Question: Write a descriptive caption for this figure.
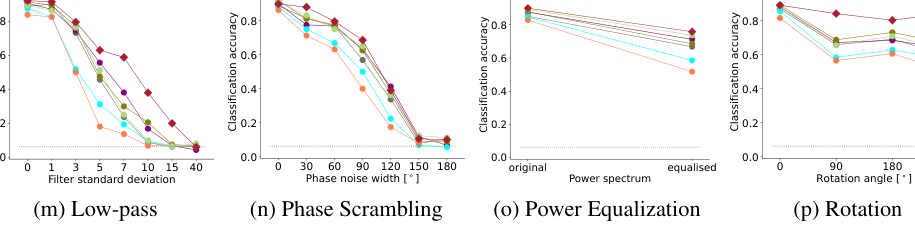
Answer: Detailed performance on 16 OOD datasets.